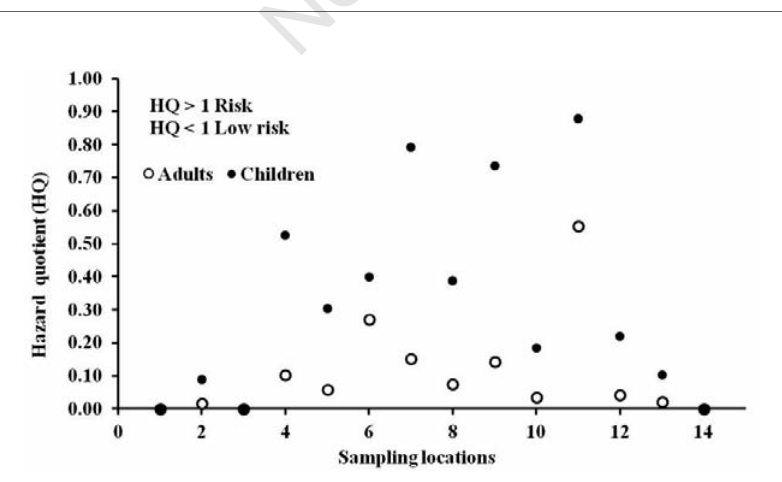
Figure 3. Health risk hazards of polychlorinated biphenyls for adults and children through soil